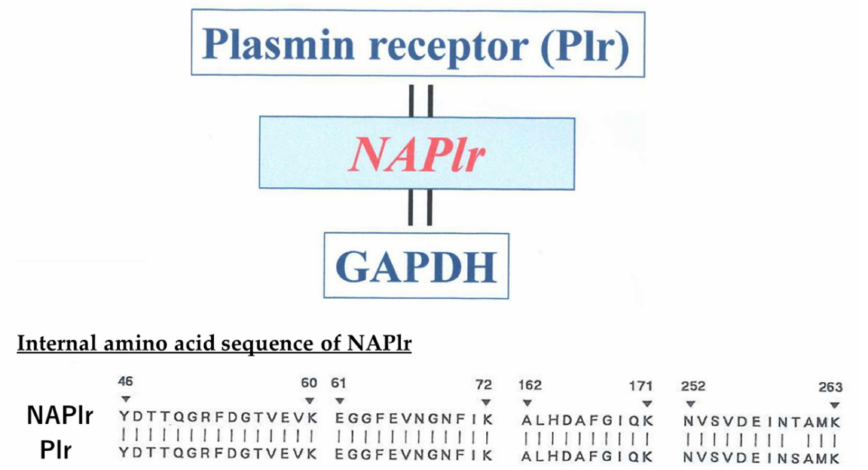
Figure 2. The amino acid and nucleotide sequences of NAPlr share high sequence identity with streptococcal Plr, as shown in the internal amino acid sequence of NAPlr. Because Plr and GAPDH are already established to be the same molecules, these three proteins are considered identical. NAPlr: nephritis-associated plasmin receptor, GAPDH: glyceraldehyde-3-phosphate dehydrogenase, Plr: plasmin